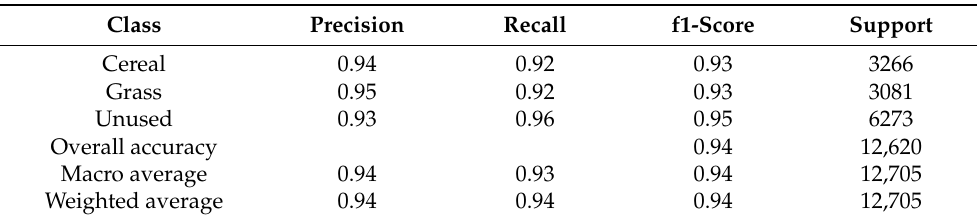
Table 3. Classification accuracies of the 2D CNN applied to the Sentinal-2 satellite image time series (SITS) data with 7 days temporal interval.